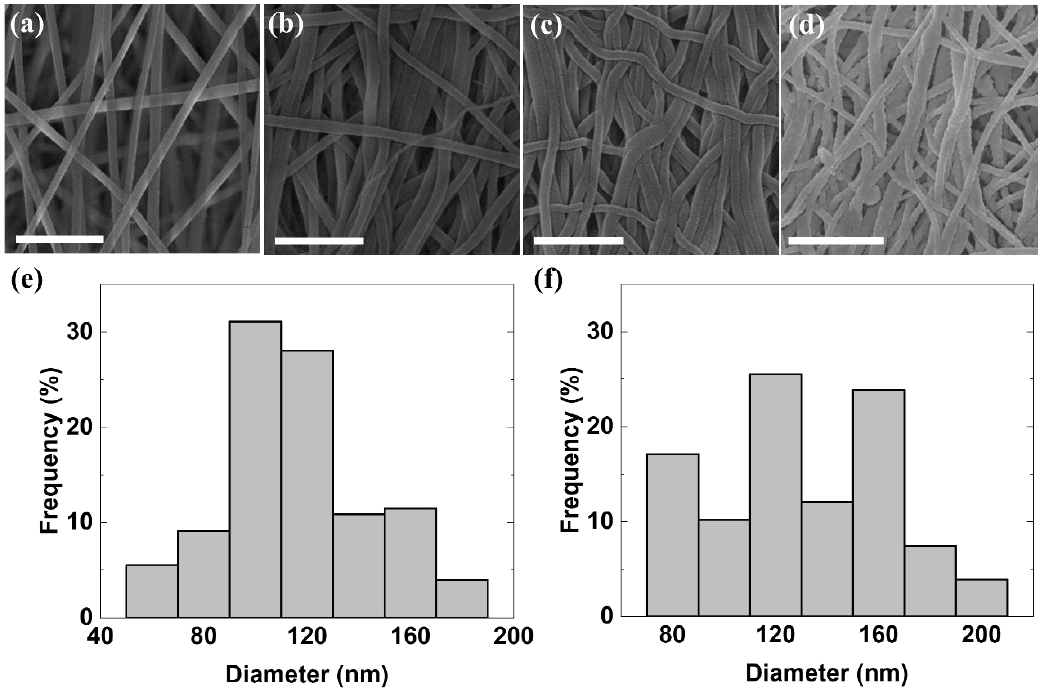
Figure 3. SEM images, which were taken in order of the fabrication process of E-50, of ( a ) As-spun NFs, ( b ) Ethanol-treated NFs, ( c ) An ethanol-treated and then hot-pressed mat, and ( d ) An Ag-deposited hot-pressed mat and corresponding diameter distributions of ( e ) As-spun NFs and ( f ) Ethanol-treated and hot-pressed mat. The ethanol treatment was applied to the as-spun mats before the hot-pressing process to increase adhesion between the NFs. All the scale bars indicate 1 µ m. The average diameter and the diameter distribution were measured from five di ff erent SEM images of the mats using Image J software (National Institutes of Health, Bethesda, MD, USA). The average diameters of the as-spun and ethanol-treated and hot-pressed mats are 116.0 nm and 130.7 nm, respectively. It was thought that the average diameter of the NFs slightly increased during the fabrication processes.